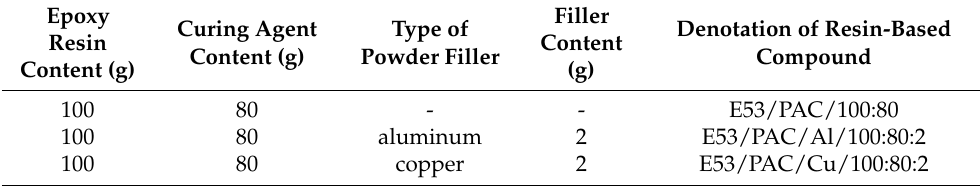
Table 1. Compositions of epoxy